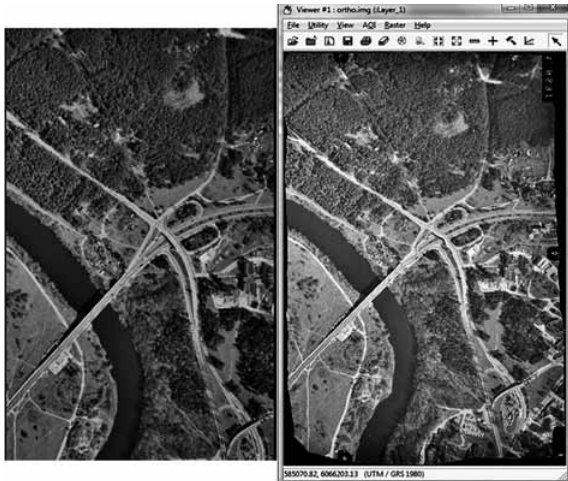
Fig. 4. Generated orthophotos in DDPS (left) and LPS (right)